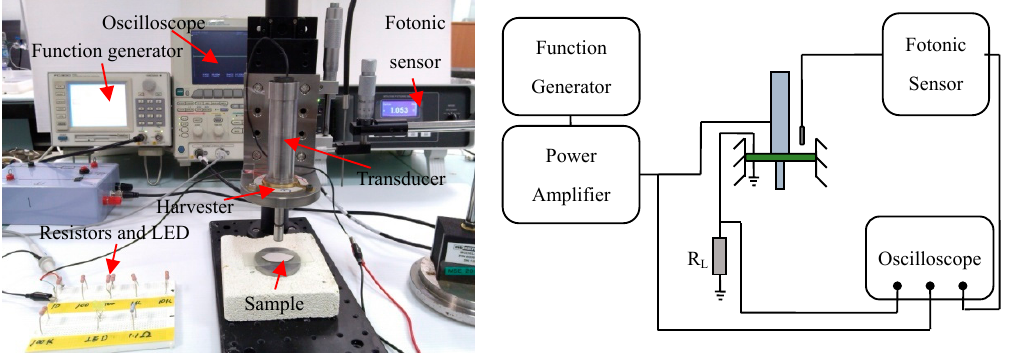
Figure 5. Piezoelectric energy harvester characterization setup.